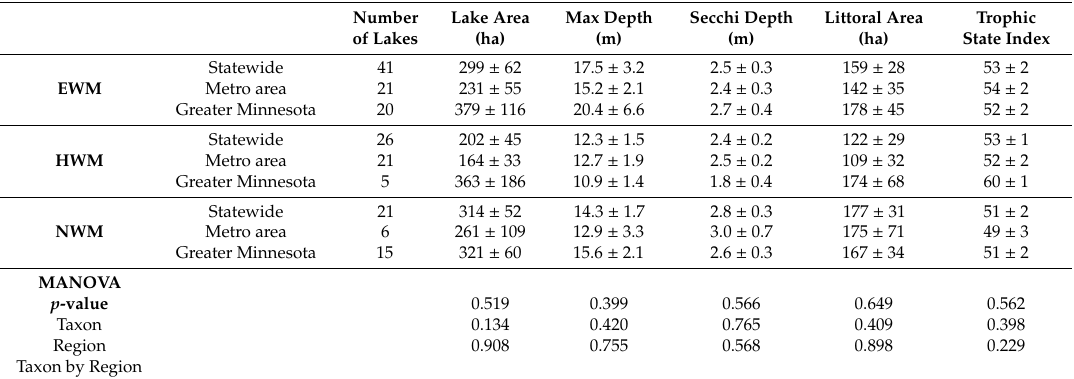
Table 3. Mean values and standard errors for environmental variables of lakes classified as containing either Eurasian (EWM), hybrid (HWM), or northern (NWM) watermilfoil. Multivariate analysis of variance (MANOVA) p -values are given for taxon, region, and taxon by region.